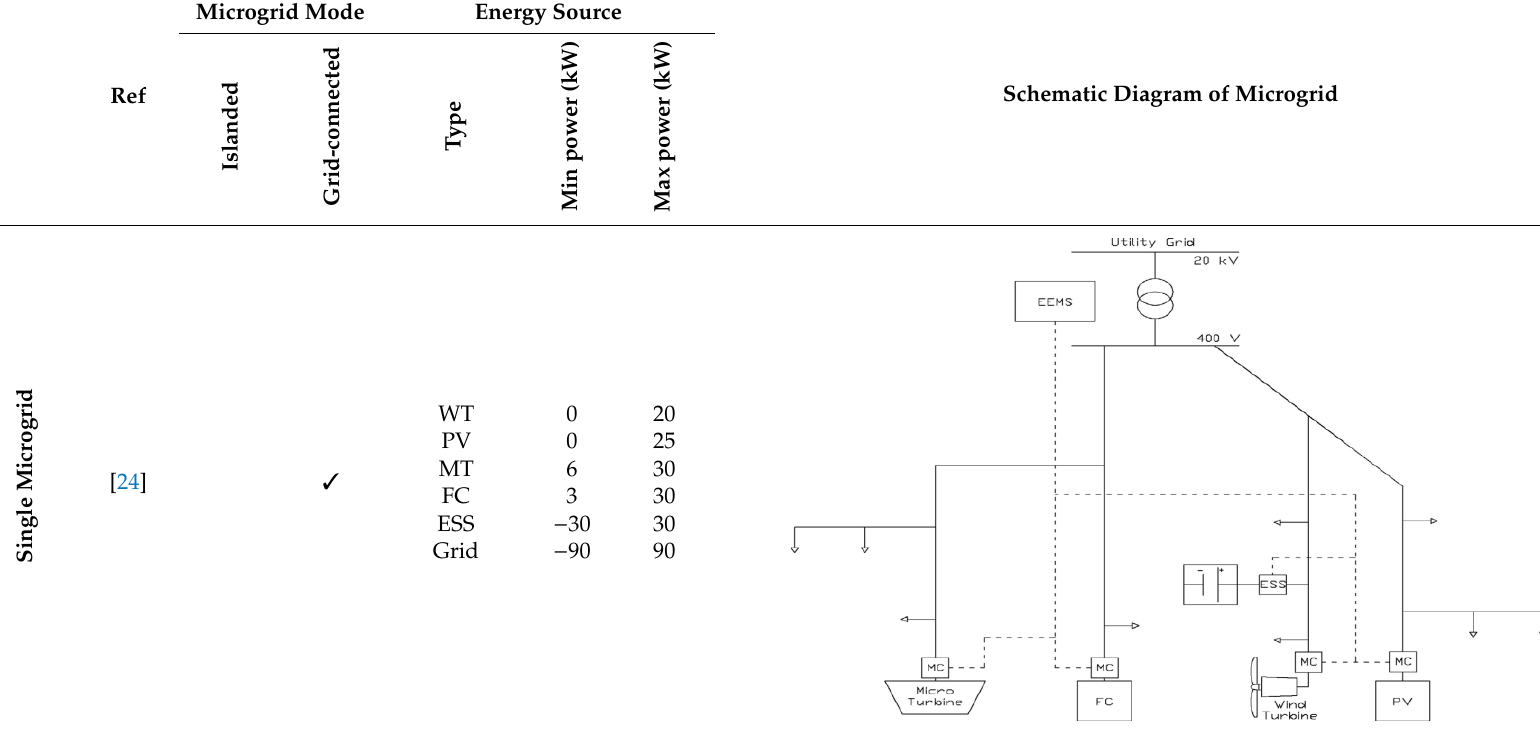
Table 4. Review of understudying microgrid test systems.